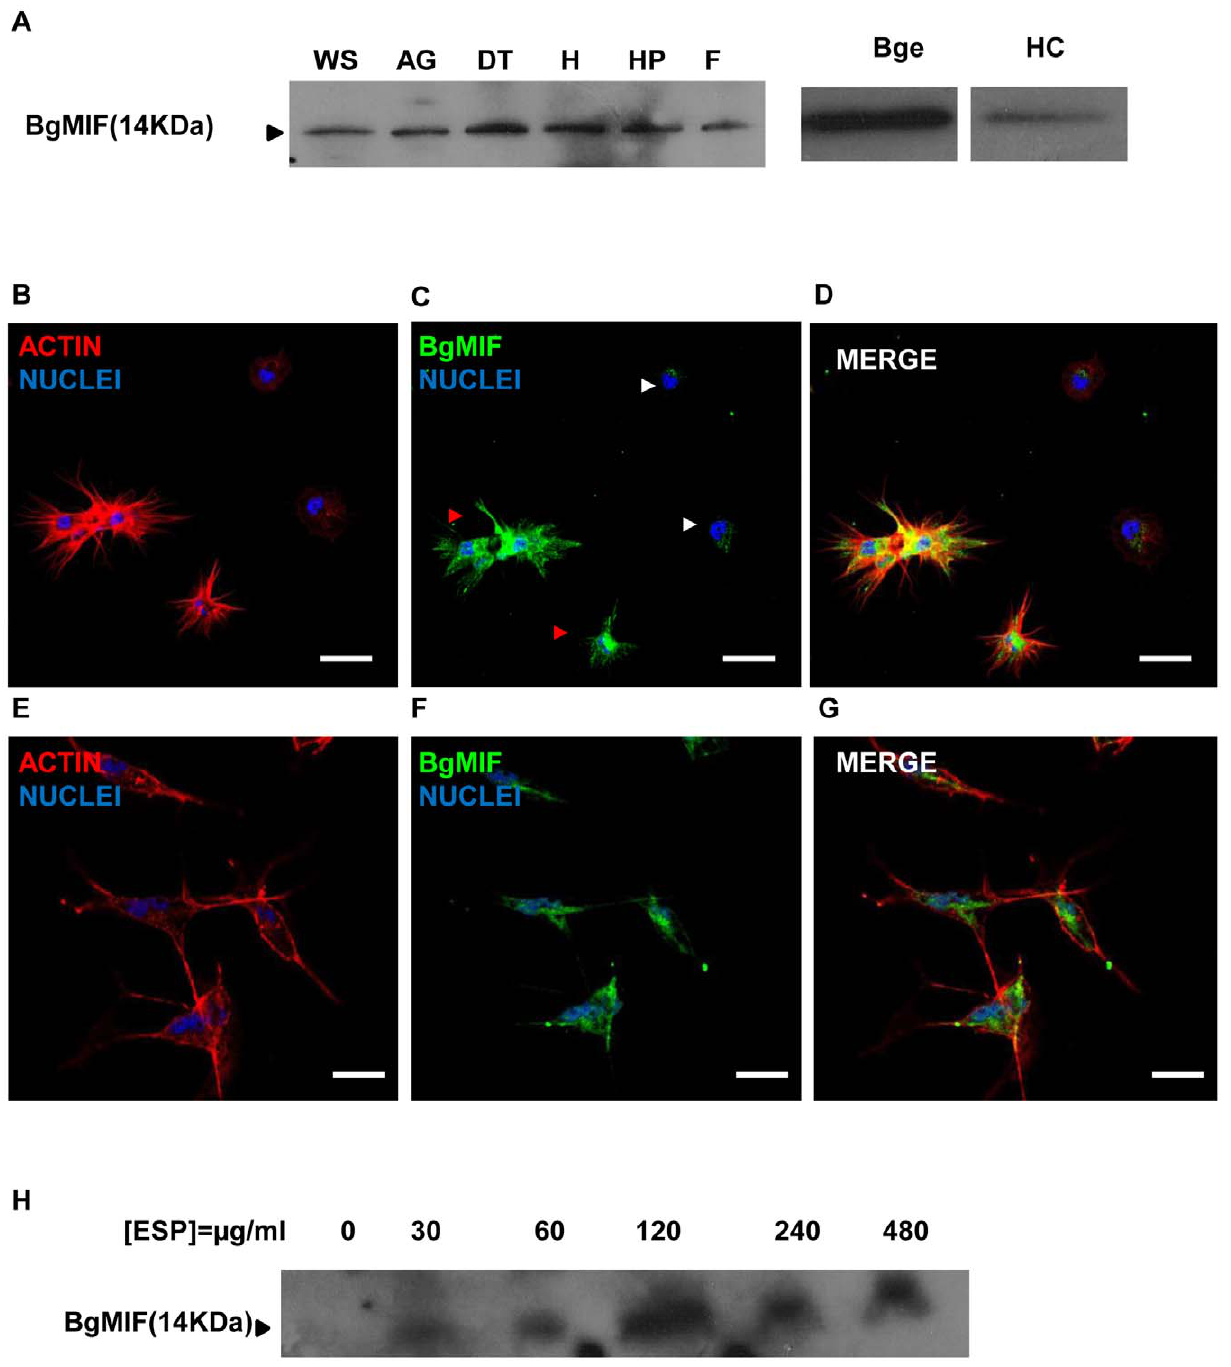
Figure 3. Expression of BgMIF. (A) BgMIF is detectable in various snail tissues. Western blotting using an antiserum directed against a peptide derived from BgMIF detects the protein as a single band in whole snails (WS), albumen gland (AG), digestive tract (DT), heart (H), hepatopancreas (HP), and foot (F), as well as in hemocytes (HC) and Bge cells (Bge). (B–D) Immunolocalization of BgMIF in hemocytes. Hemocytes were labeled with phalloidin (actin label) and Hoechst (B), with anti-BgMIF and Hoechst (C) or all three labels (D). Note that BgMIF labeling is much less visible in two unspread hemocytes (white arrows) compared to spread hemocytes exhibiting pseudopods (red arrows). Scale bar represents 12 m m. (E–G) Immunolocalization of BgMIF in Bge cells. Cells were labeled with phalloidin (actin label) and Hoechst (E), with anti-BgMIF and Hoechst (F) or all three labels (G). Scale bar represents 12 m m. (H) Immunoblotting of Bge cell culture supernatants with anti-BgMIF antibody. Cells were exposed to increasing concentrations of S. mansoni ESP (30–480 m g/mL).